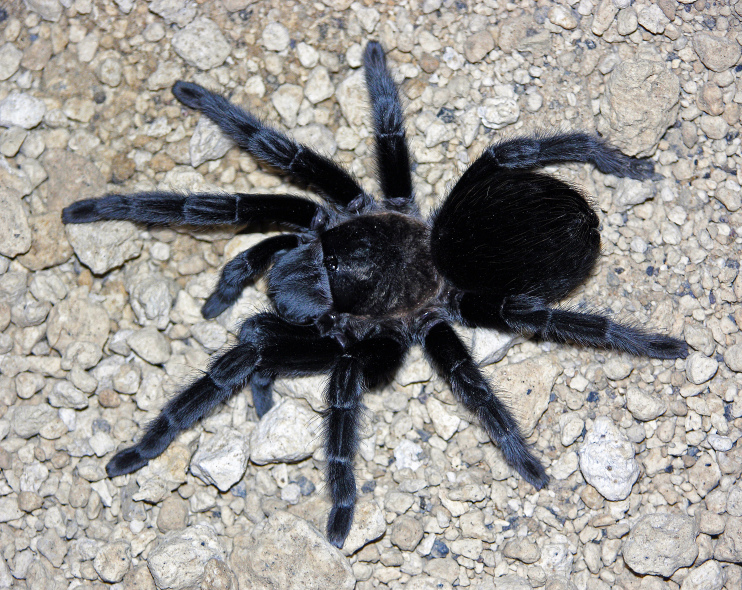
Brachypelma
schroederi Rudloff, 2003 female from Mitla, Oaxaca state, Mexico. Photo: Rick C. West.